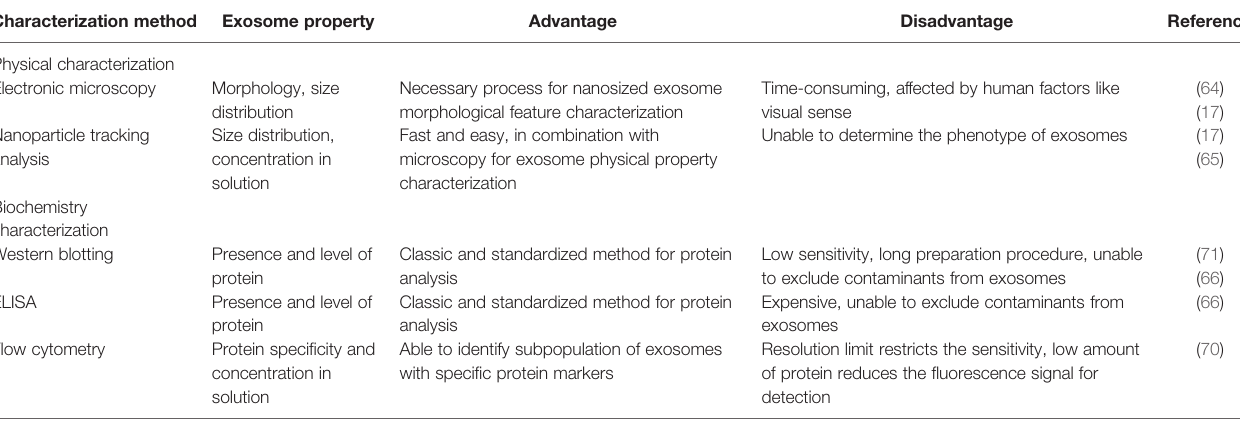
TABLE 2 | Comparison of different exosome characterization